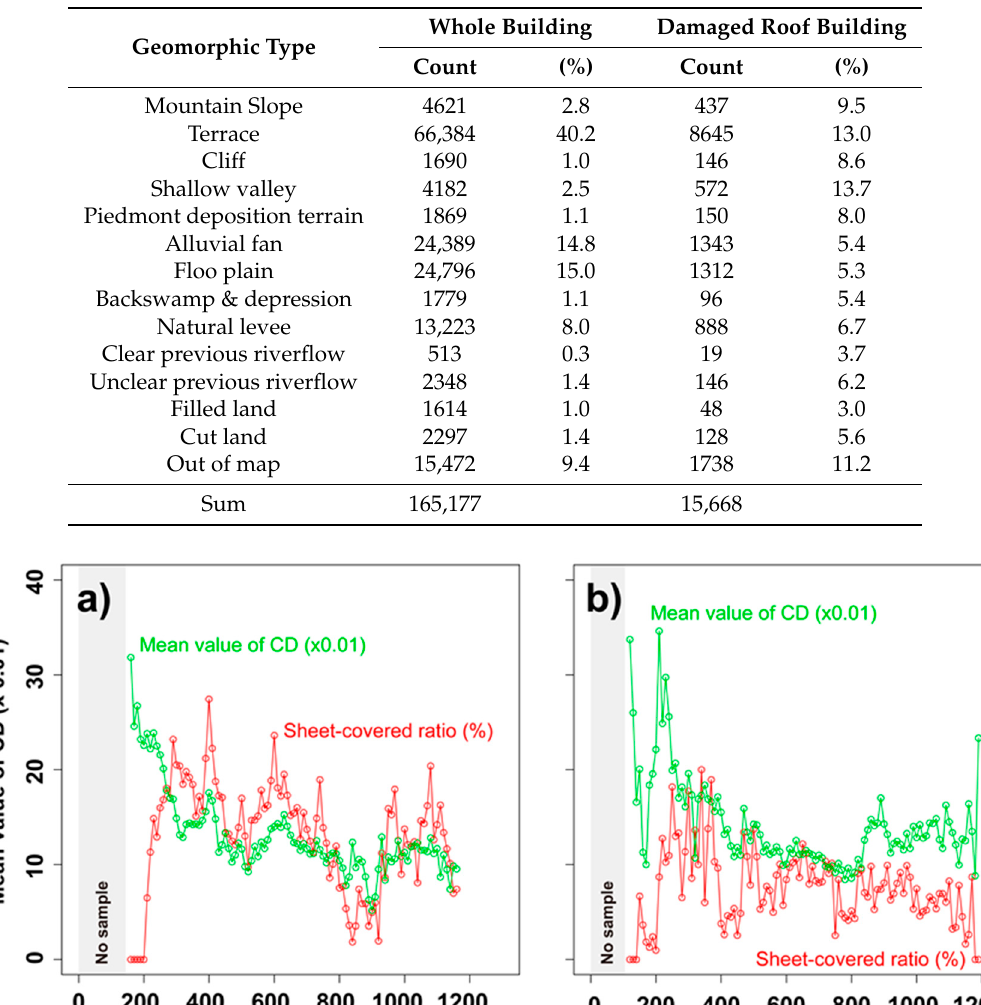
Table 2. Summary of entire buildings and damaged-roof buildings.